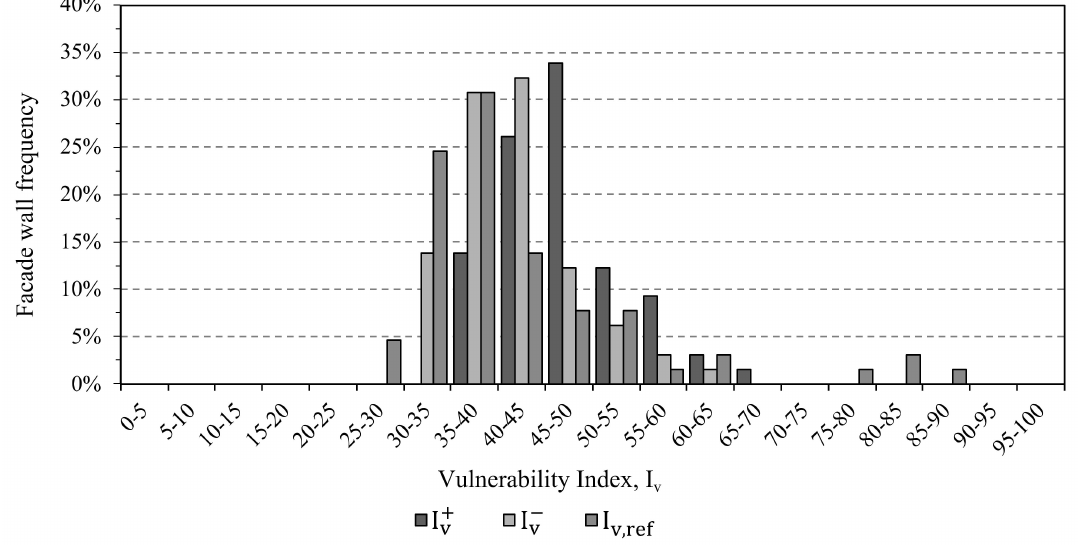
Figure 14. Vulnerability index distributions obtained from I v,ref and overall comparison. The hypoth- esis of normality was not sustained in this approach.